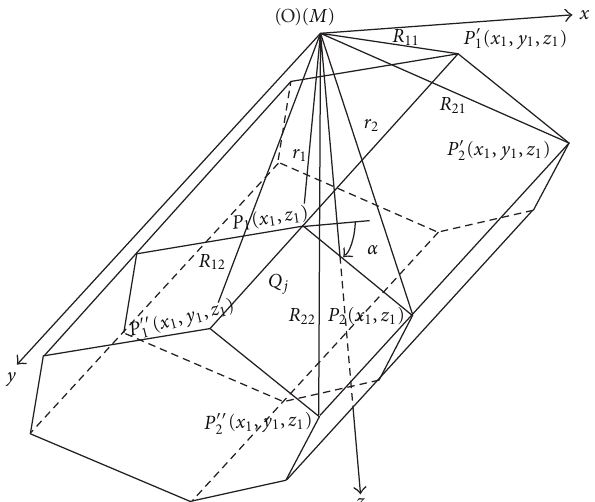
Figure 3: Computing derivatives of gravity potential for a horizon- tal polygonal